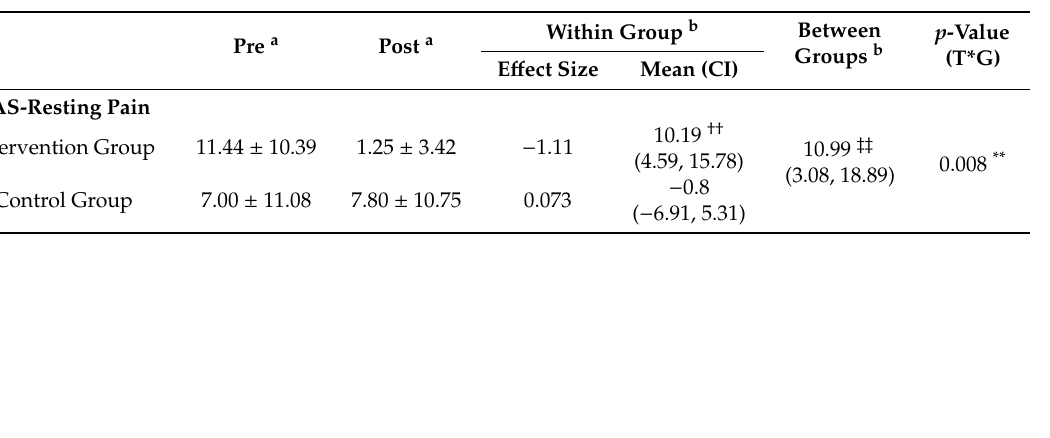
Table 3. The changes in pain intensity and PPT (pain pressure